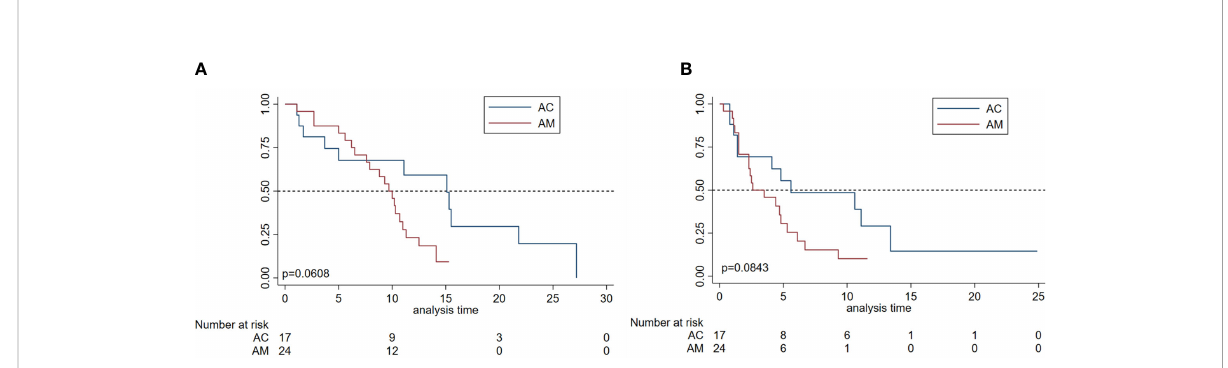
FIGURE 3 Survival analyses by subgroup in patients with metastatic osteosarcoma. (A) Overall survival and progression-free survival (B) of patients according to the apatinib monotherapy group (AM) and apatinib plus chemotherapy treatment group (AC).